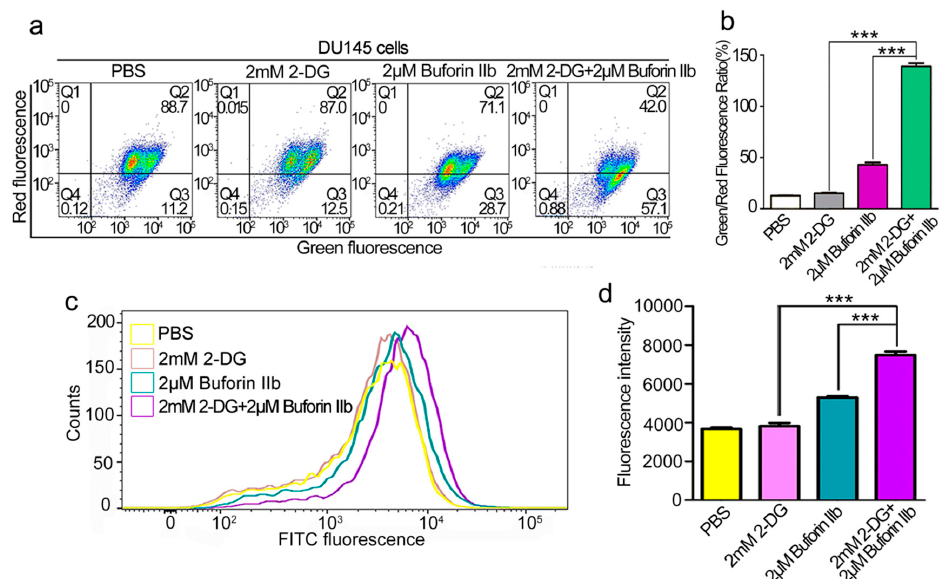
Figure 5. Effects of 2-DG and buforin IIb alone or in combination on mitochondria in DU145 cells. ( a ) DU145 cells pretreated with or without 2-DG (2 mM) for 12 h were incubated with buforin IIb (2 μ M) for 12 h, followed by staining with JC-1 and flow cytometry at 490 nm and 525 nm excitation. The emitted light was detected at 590 nm (red) and 530 nm (green). ( b ) The mitochondrial membrane potential was expressed as the ratio of green to red fluorescence intensity. ( c ) DU145 cells pretreated with or without 2-DG (2 mM) for 12 h were incubated with buforin IIb (2 μ M) for 6 h, and then stained with H2DCFDA for 30 min. Cells were analyzed by flow cytometry at 488 nm excitation. ( d ) Statistical analysis of fluorescence intensity from ( c ). *** p < 0.001.